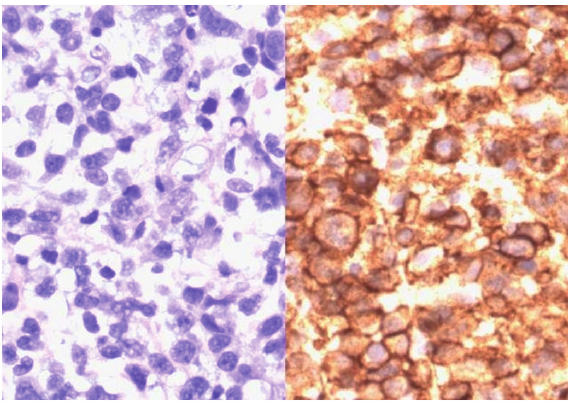
Figure 1: Abdominal CT scan showing large bilateral adrenal mas- ses of homogenous appearance. No other pathology was demon- strated.